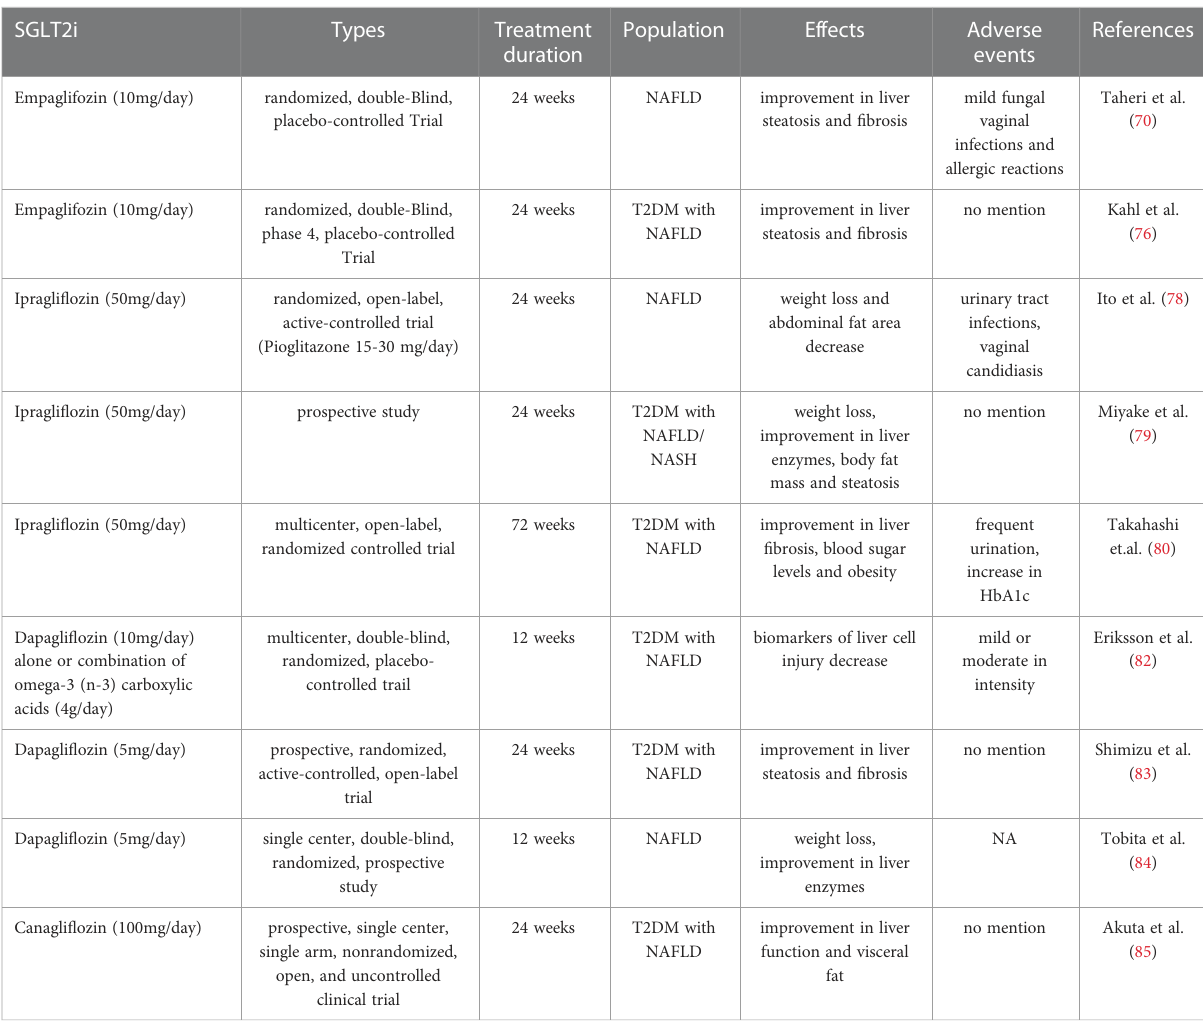
TABLE 2 Effect of SGLT2i in patients of NAFLD/NASH: Data from clinical studies.